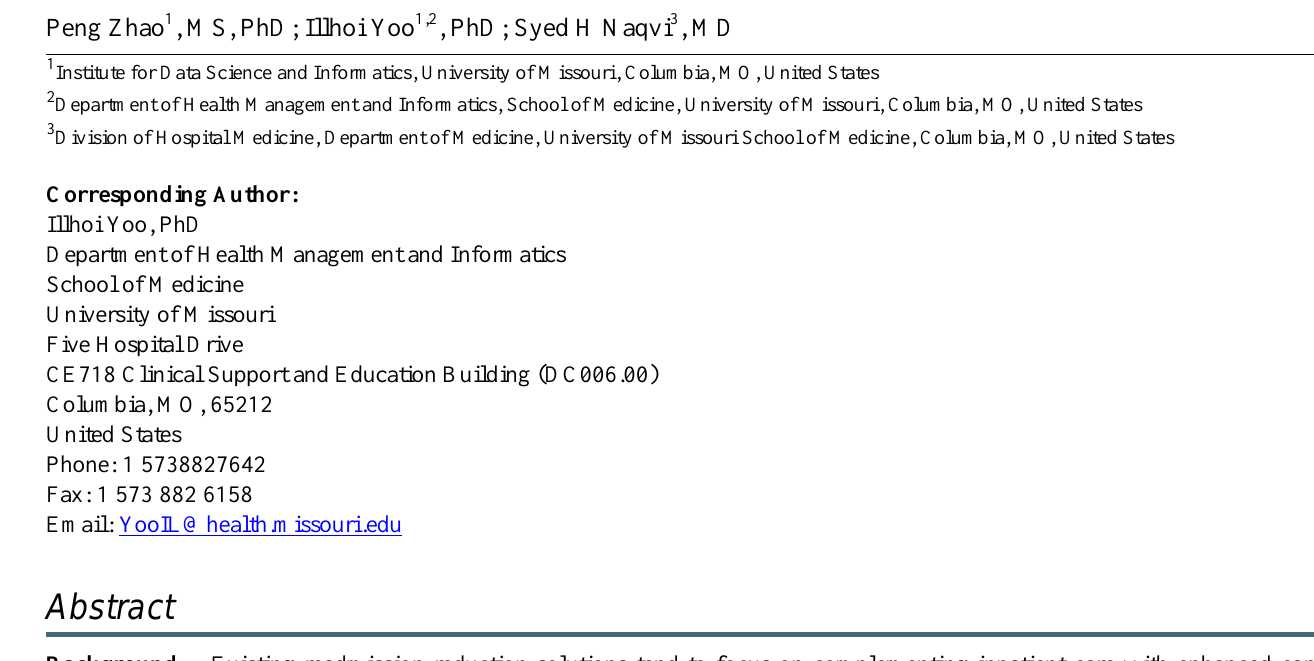
patient readmission; risk factors; unplanned; early detection; all-cause; predictive model; 30-day; machine